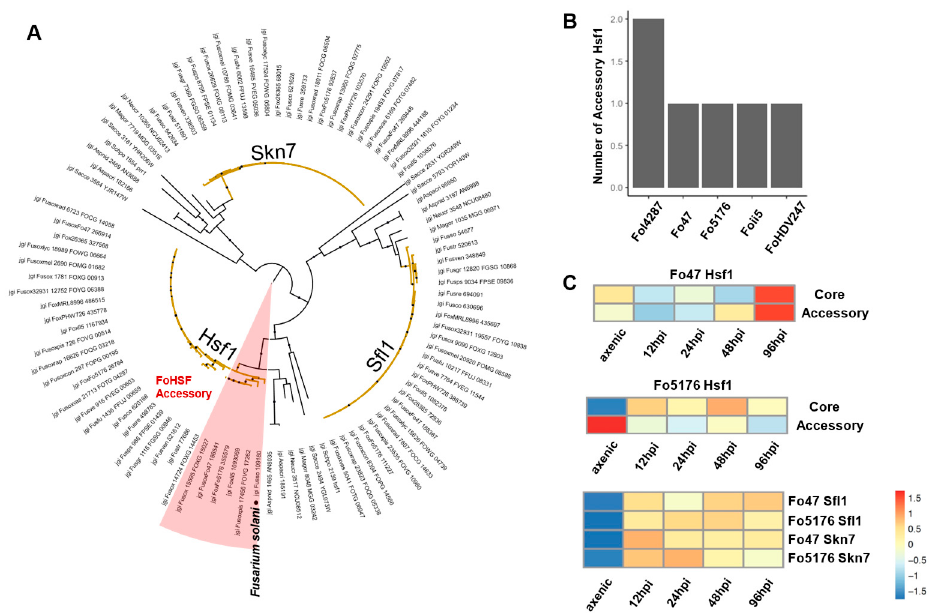
Figure 3. Evolutional trajectory of heat shock factors (HSFs) suggests genome expansion and adaptation. ( A ) Phylograms of HSFs were constructed by the maximum likelihood method with 1000 bootstraps. Branches of Fusarium HSFs are colored in yellow. Accessory HSFs of FOSC are shaded in red. ( B ) Number of accessory HSFs in some FOSC genomes. ( C ) Expression of HSF genes during plant colonization (hpi indicates hours post inoculation) compared to axenic growth. Transcriptome data were previously described in Guo et al. 2021 [24]. See Section 2 for details of the data reprocessing and visualization.